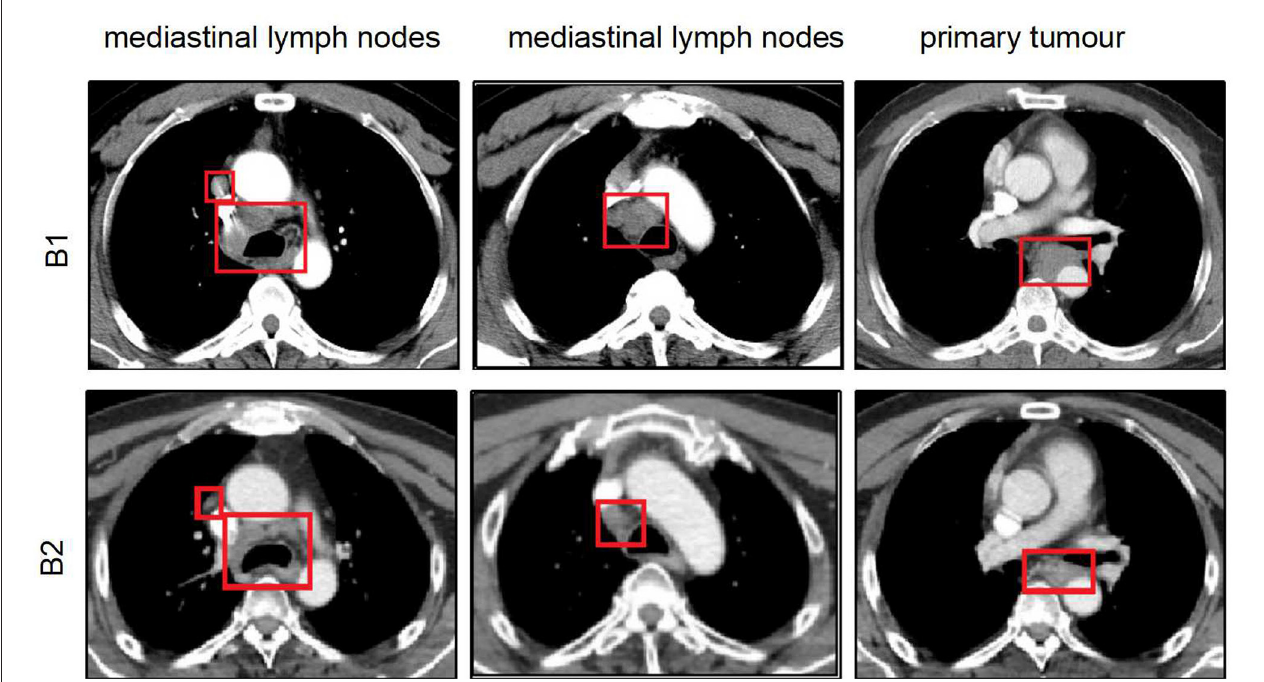
FIGURE 15 | Comparison of chest CT scan between before and after treatment for the second patient. (B1) Chest CT showing that thickened esophageal wall and the enlarged lymph nodes in the mediastinum with an outcome of PD after patient underwent four cycles of chemotherapy. (B2) Chest CT scan representing that the primary tumor mass reduced in size and the enlarged lymph nodes in the mediastinum shrank or became loosened with an outcome of PR after anlotinib combined with radiotherapy and two cycles of chemotherapy. CT, computed tomography; PD, progressive disease; PR, partial progressive